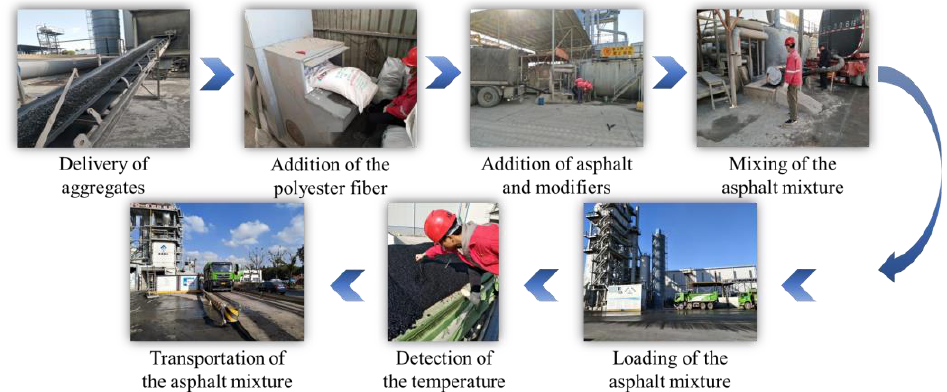
Figure 5. Preparation and transportation procedures of the HWU asphalt mixture.